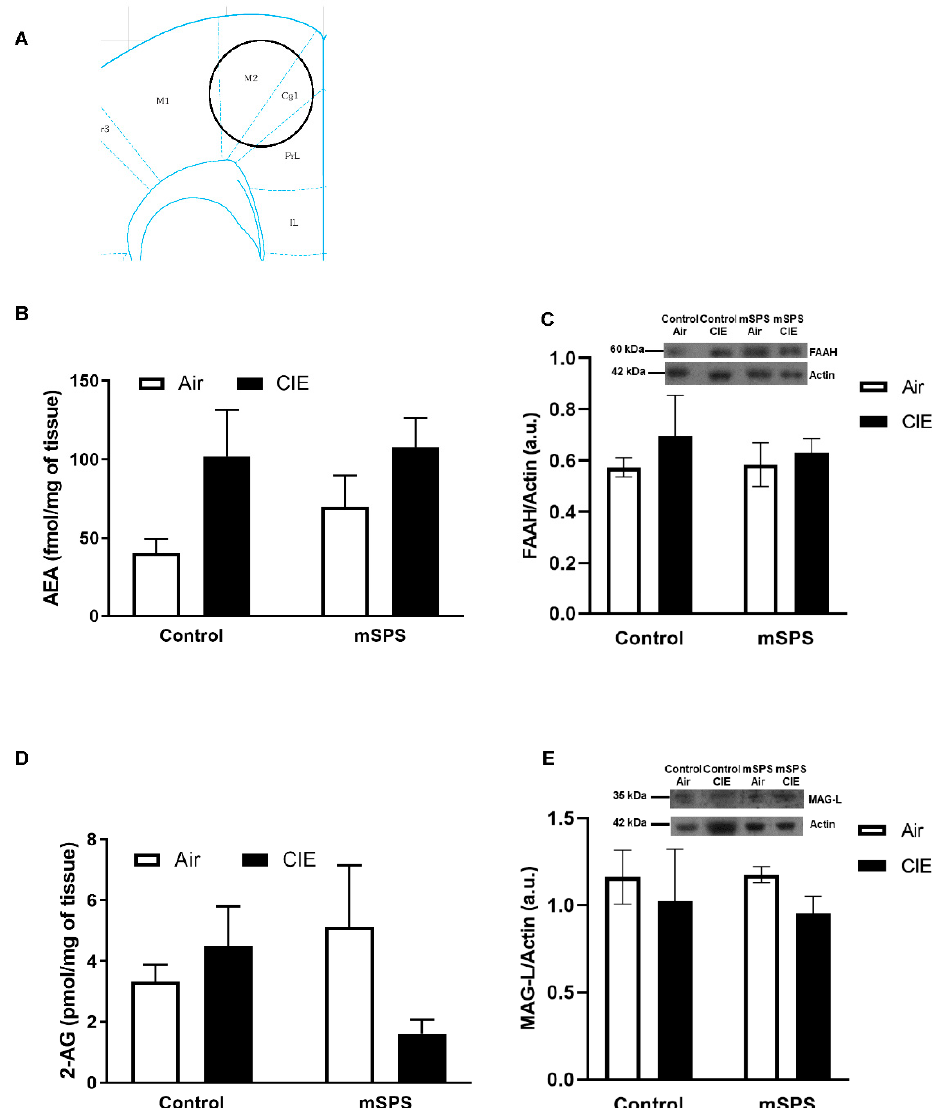
Figure 1. Anandamide (AEA) and 2-arachidonoylglycerol (2-AG) contents, fatty acid amide hy- drolase (FAAH) and monoacylglycerol lipase (MAG-L) levels in the prefrontal cortex (PFC) after mSPS/Control or Air/CIE exposures. ( A ) Schematic of coronal slice where PFC tissue punches were taken bilaterally (adapted from [58]). Average ( B ) AEA content (Control-Air: n = 4; Control CIE: n = 7; mSPS-Air: n = 6; mSPS-CIE: n = 8) ( C ) FAAH levels (Control-Air: n = 6; Control CIE: n = 4; mSPS-Air: n = 5; mSPS-CIE: n = 8) (Inset: representative immunoblotting sample images; kDa kilodaltons) ( D ) 2-AG content (Control-Air: n = 4; Control CIE: n = 7; mSPS-Air: n = 6; mSPS-CIE: n = 8), and average ( E ) MAG-L levels (Control-Air: n = 7; Control CIE: n = 4; mSPS-Air: n = 4; mSPS-CIE: n = 7) in the PFC (Inset: representative immunoblotting sample images) did not change among groups after mSPS/Control or Air/CIE exposures. Data are mean ± SEM.